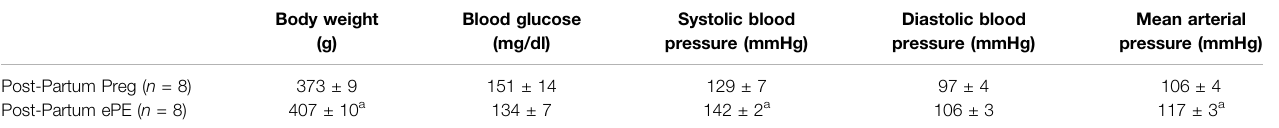
Body weight Blood glucose Systolic blood Diastolic blood (g) (mg/dl) pressure (mmHg) pressure (mmHg)